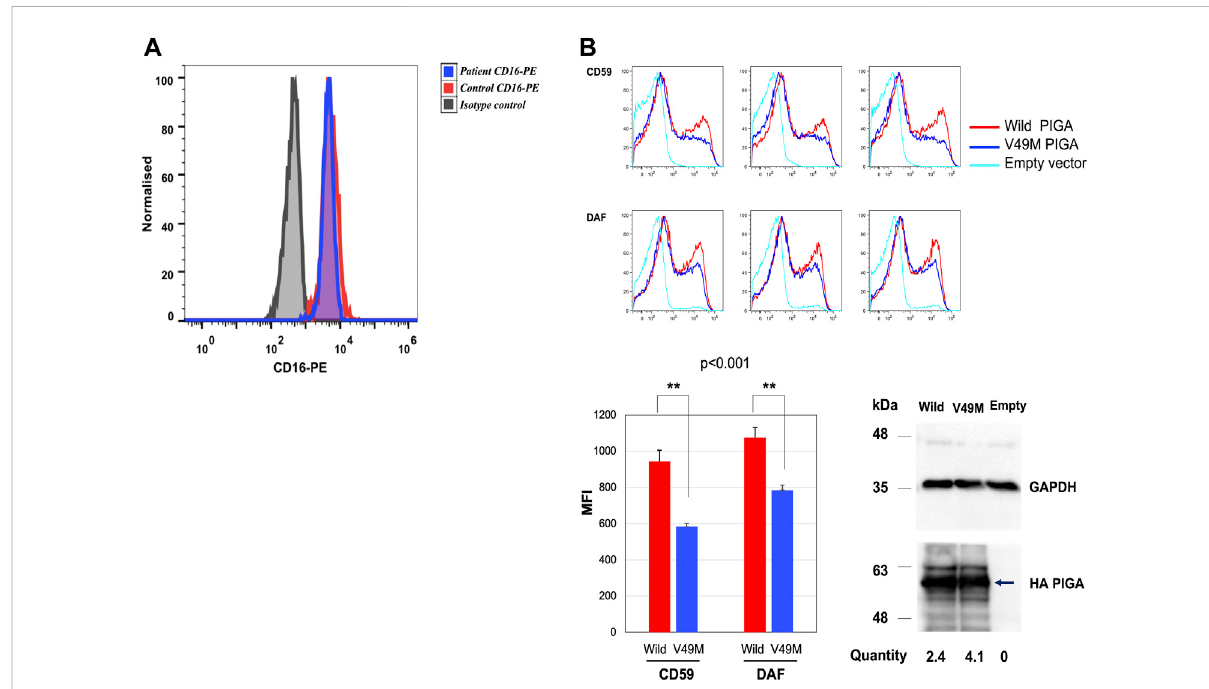
FIGURE 3 CD16expressioningranulocytesandrescueanalysisinthePIGA-KOHEK293cells. (A) Histogramdepictingmedian fl uorescenceintensity(MFI) of CD16-PE in granulocytes from the patient (blue histogram) and healthy control (red histogram) (healthy control MFI = 5,130 vs. patient MFI = 4,450). (B) RescueofCD59andDAFexpressiononthePIGA-KOHEK293cellsusingaweakTATAboxonlypromoter(pTA).Thehistogramsrepresent the MFI for the rescue of CD59 and DAF expression by the wild type and Val49Met (V49M) variant using the pTA promoter. Values for three independent experiments and their statistical signi fi cance were graphed. CD59: wild type MFI = 943 vs. variant MFI = 584. DAF: wild type MFI = 1,074 vs. variant MFI = 785. Representative Western blotting of the mutant (Val49Met) and wild type (Wild) PIGA protein expression showing that the PIGA mutant protein was more expressed than the wild-type protein. (normalized with the intensities of GAPDH, the loading control, and